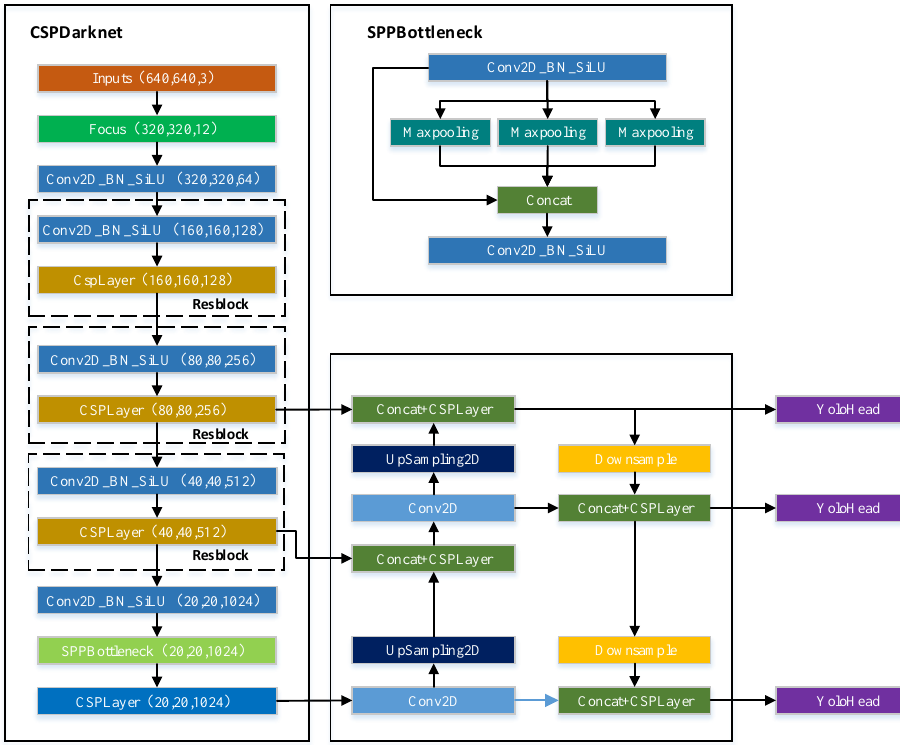
Figure 5. Model structure of YOLOv5.